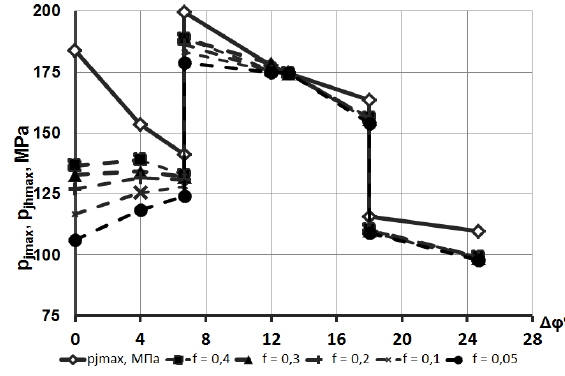
Figure 3. The change of the maximum contact pressures in the process of two teeth pairs – single tooth pair – two teeth pairs engagement and wear in MM gear trains